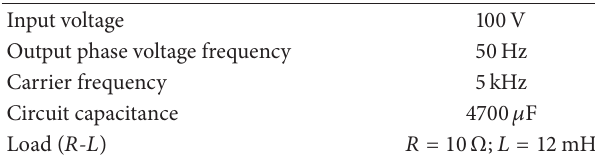
Table 3: Circuit parameters considered in simulation